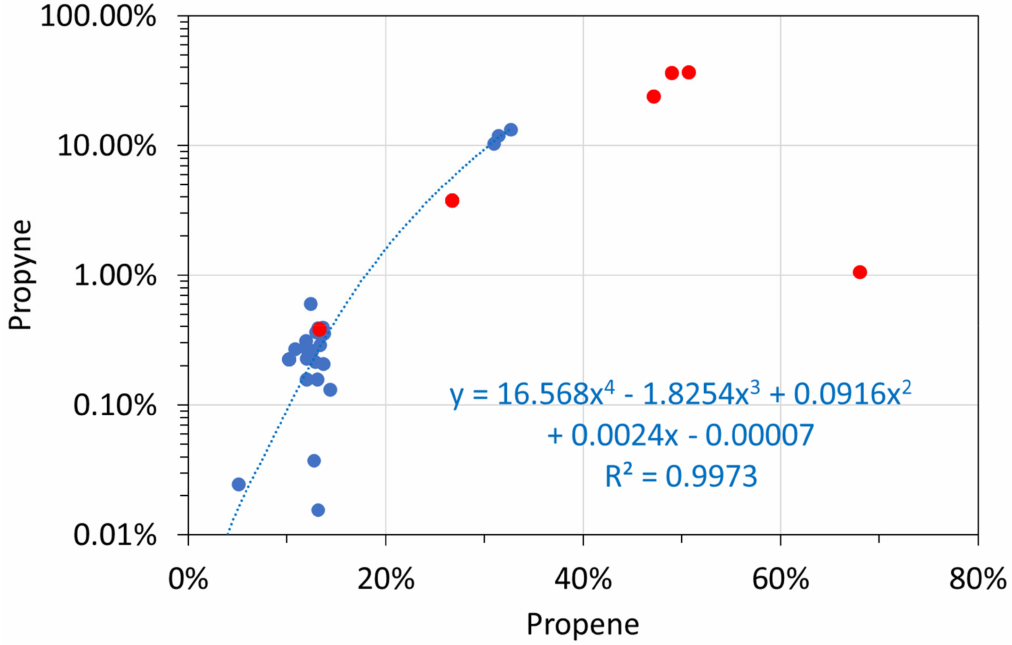
Figure A6. Molar alkane gas analyses: propene vs. propyne. Blue circles: T ≤ 298 K; red circles: T = 348